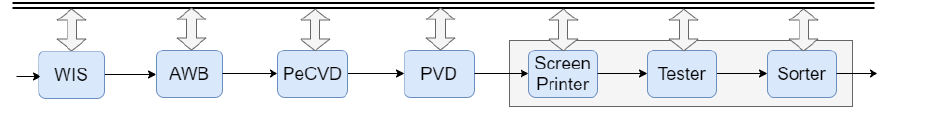
Figure 1. Photovoltaic cell production line in the 3SUN